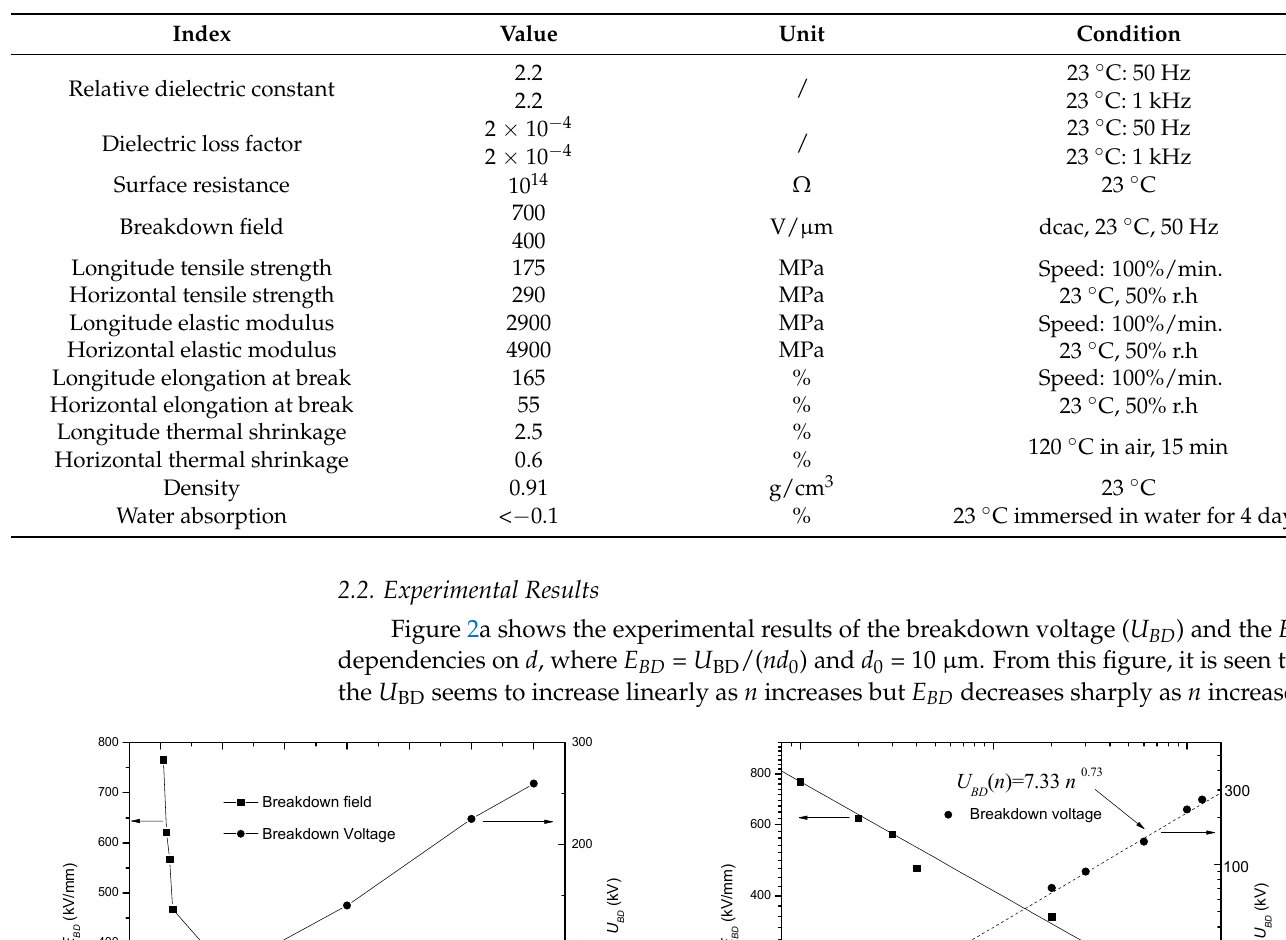
Table 1. Key parameters of the PP films [28].